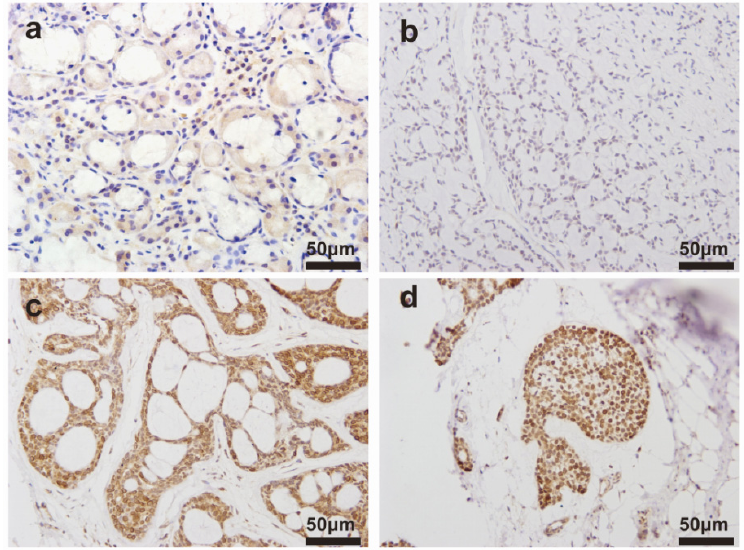
Figure 2. Western blot analysis on the expression of SOX2 in ACC tissue and